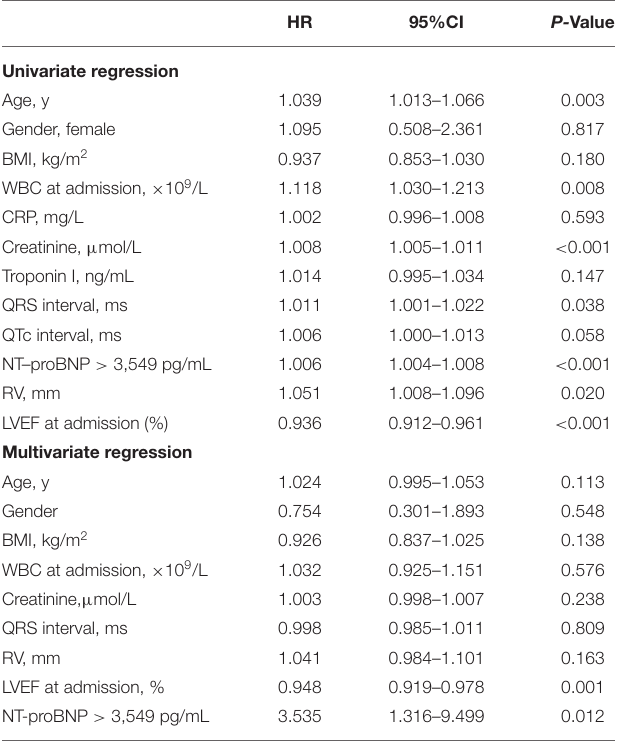
TABLE 2 | Univariate and Multivariate Cox Analysis for Long-term MACE. TABLE 3 | Univariate and multivariate cox analysis for 30-day death or heart